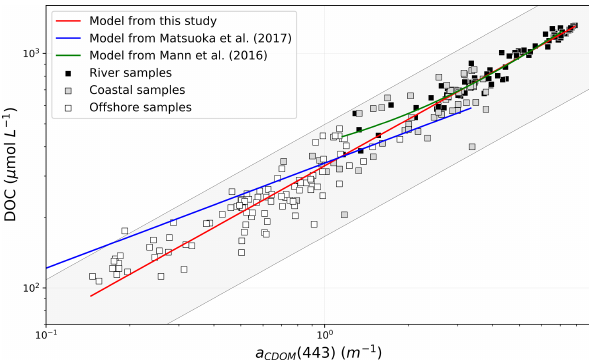
Figure 5. Relationship between a CDOM (443) and DOC ( r 2 = 0 . 96). Red line shows the derived model from this dataset. The blue line shows the relationship from Matsuoka et al. (2017) for a pan- Arctic dataset for offshore and coastal waters. The green line shows the relationship for Lena River water from Mann et al. (2016). The filled grey area shows the 50% error range. Note that the axes are displayed in log